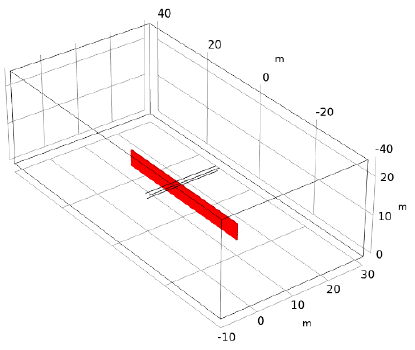
Table 4. FFT operation time.